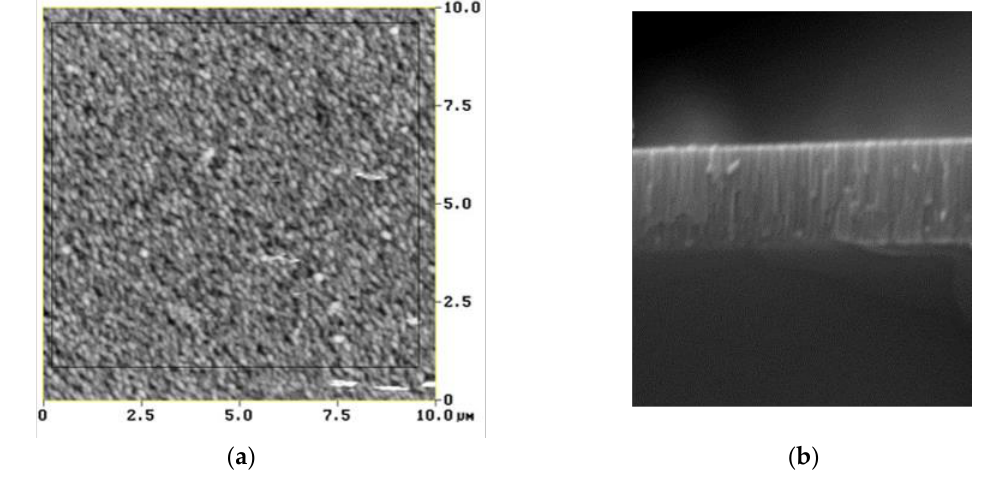
Figure 2. ( a ) The atomic force microscopy (AFM) and ( b ) the scanning electron microscopy (SEM) photo of the ZnO film.